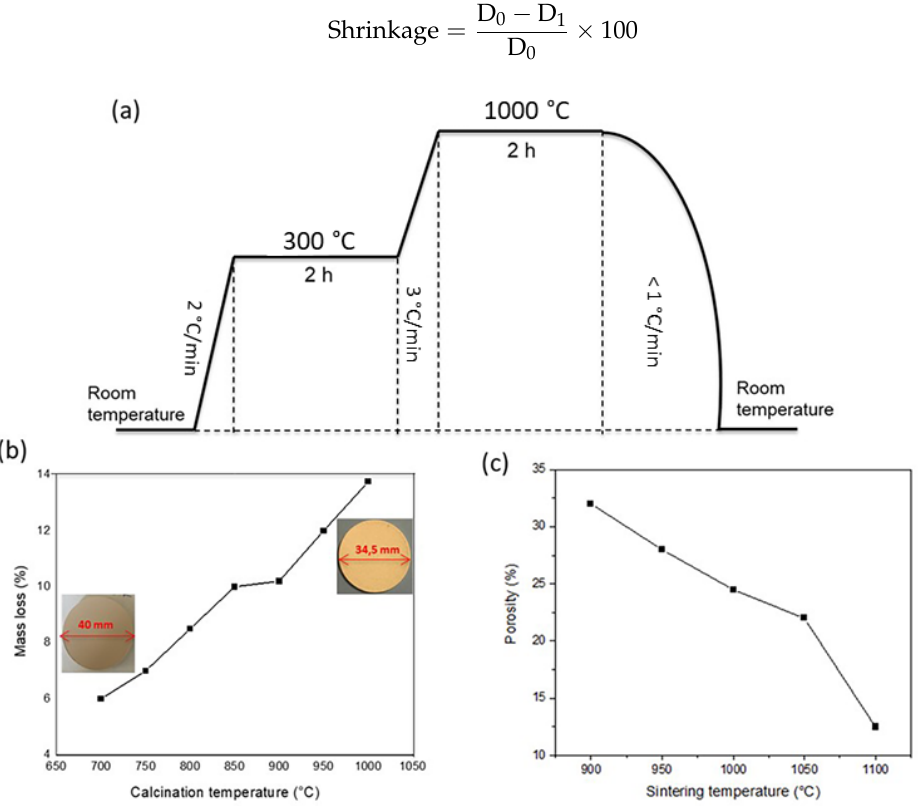
Figure 1. ( a ) Scheme of the thermal treatment program; ( b ) mass loss as a function of calcination temperature of the ceramic support made of natural phosphate; ( c ) variation of phosphate ceramic support porosity vs. sintering temperature.